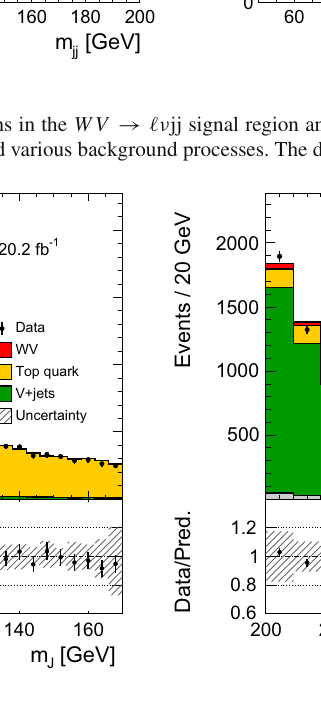
background prediction (which is part of the “ V + jets” histogram) in the W + jets CR. The hatched bands indicate the systematic uncertainty of the prediction. For the V + jets component, only shape systematic uncertainties are included in the